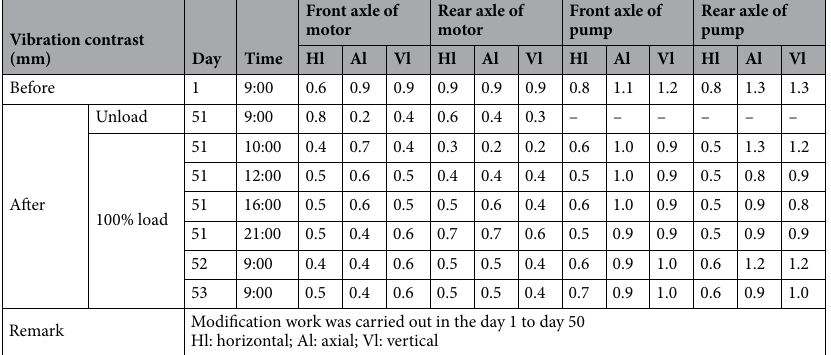
Table 4. Vibration contrast before and after using the speed regulator.